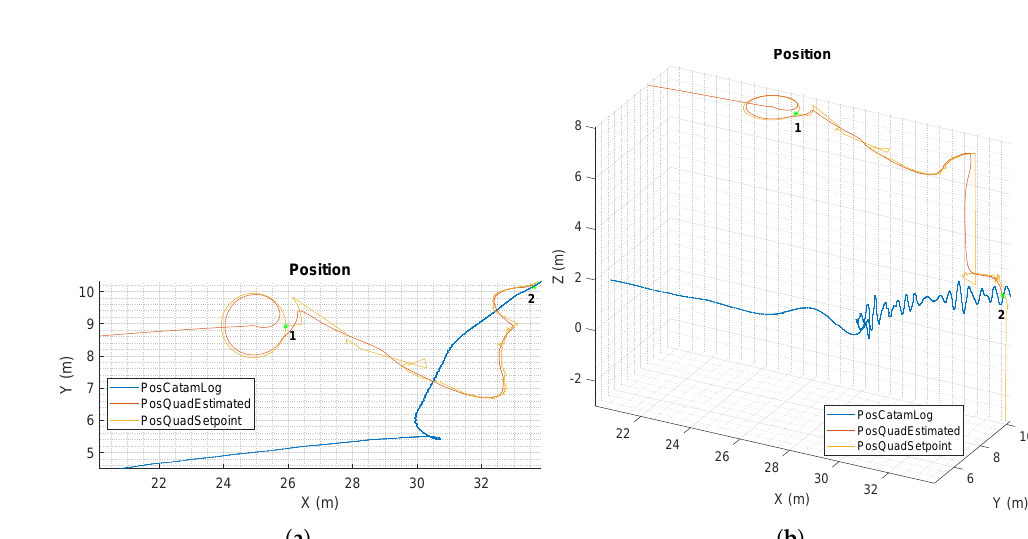
Figure 8. ( a ) Bird’s eye view of the trajectories of the UAV and of the ULISSE ASV during the simulation. 1 indicates the position at which the search radius changed, and 2 indicates where the final landing was accomplished. ( b ) A 3D representation.